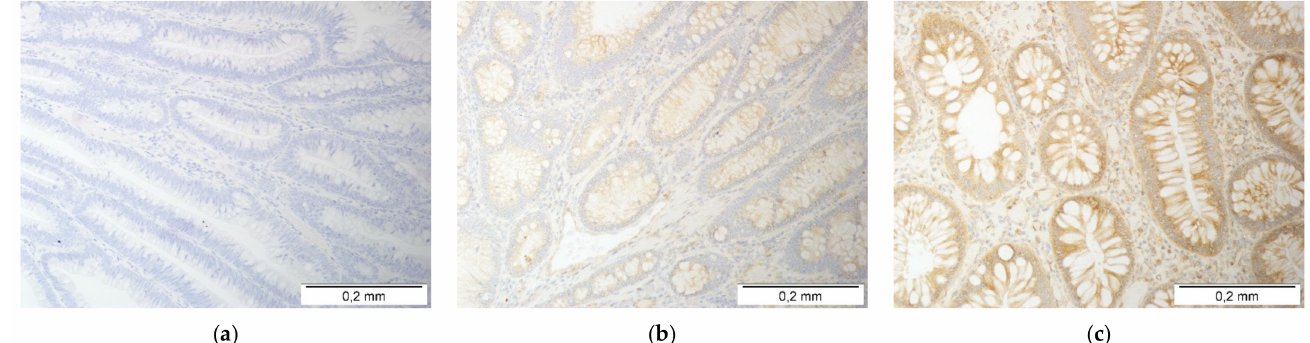
Figure 3. Immunohistochemical analysis of MCP-2/ CCL8 protein expression in colorectal adenomas: ( a ) negative reaction, showing either no reaction in the glandular epithelial cells or it only occurring in the stromal area of the lesion; ( b ) a weak cytoplasmic reaction, or the reaction did not encompass the entire lesion (score 1; +); and ( c ) a strong cytoplasmic reaction encompassing the entire lesion (score 2; ++). The tissue slides were incubated with rabbit anti-human MCP-2/ CCL8 antibodies with a DAB chromogen, stained brown in the case of a positive reaction and counterstained with hematoxylin. All the photos were taken at 200 × .